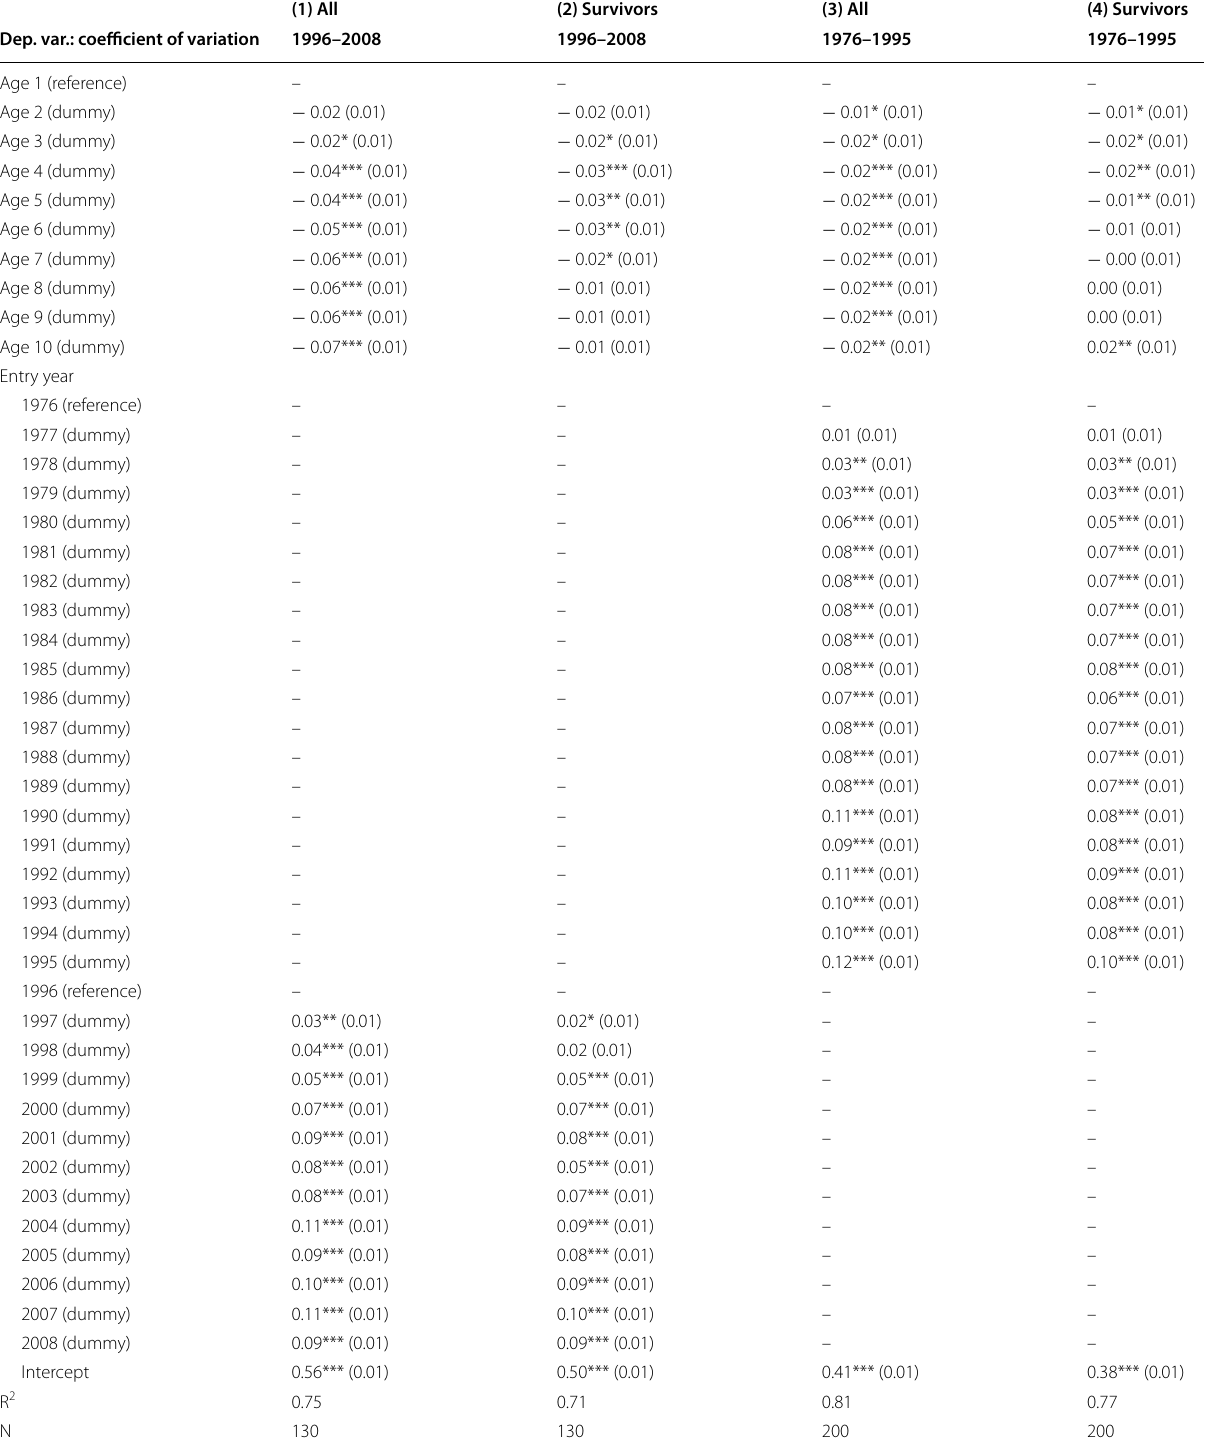
Table 1 Within- and between-cohort wage